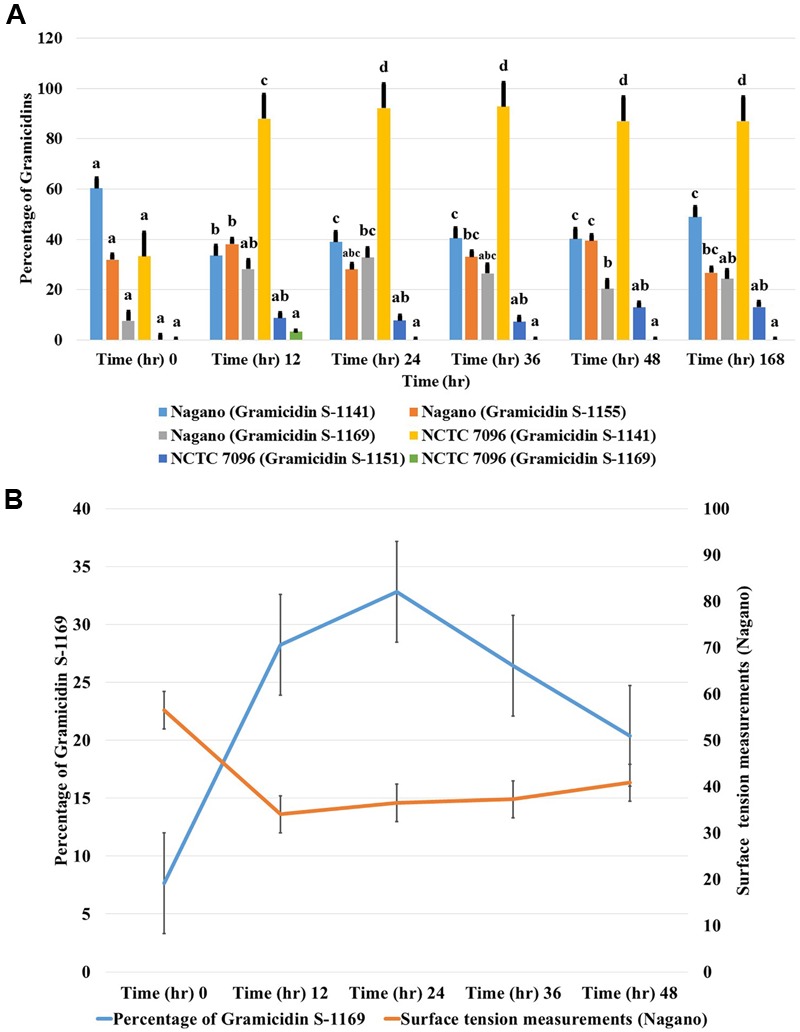
Relative concentrations of gramicidin-1141, gramicidin-1155 and gramicidin-1169 produced by (A)
A. migulanus Nagano and NCTC 7096 determined using LC-MS. (B) Relationship between changes in surface tension of A. migulanus Nagano culture fluids and production of GS-1169. Vertical bars represent standard errors of the means, N = 3. Error bars represent standard error of three independent replicates for each gramicidin (1141, 1155 and 1169). Data presents mean ± standard error. Bars labeled with different letters are significantly different among the treatments at P < 0.05 using the Tukey’s HSD test. In each bar groups, bars labeled with the same letter are not significantly different from each other according to Tukey’s HSD at p < 0.05.